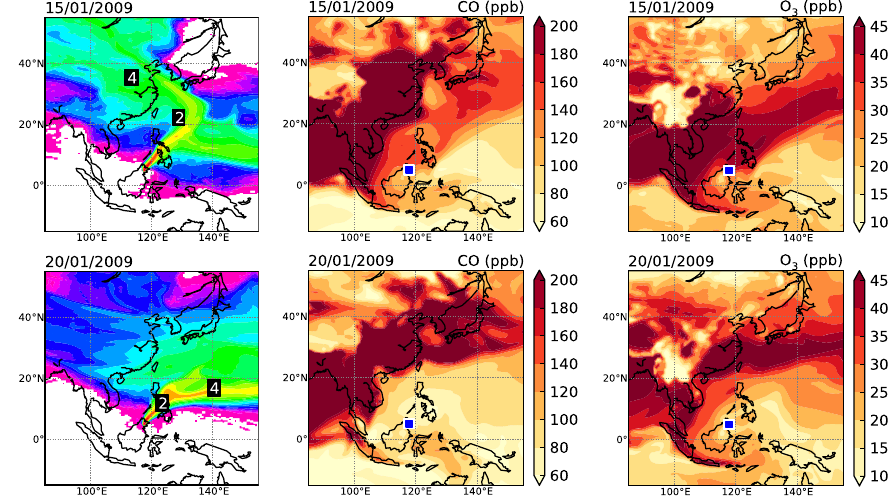
Figure 4. Daily mean air history maps calculated using NAME (left), CO at 925hPa from the MACC reanalysis (center) and O 3 at 925hPa from the MACC reanalysis (right) for 15 January 2009 (top) and 20 January 2009 (bottom). The colour scale for the air history maps is the same as in Fig. 2, and the mean horizontal location of the trajectories after 2 and 4 days is marked. In the CO and O 3 panels the location of Bukit Atur is marked with a blue